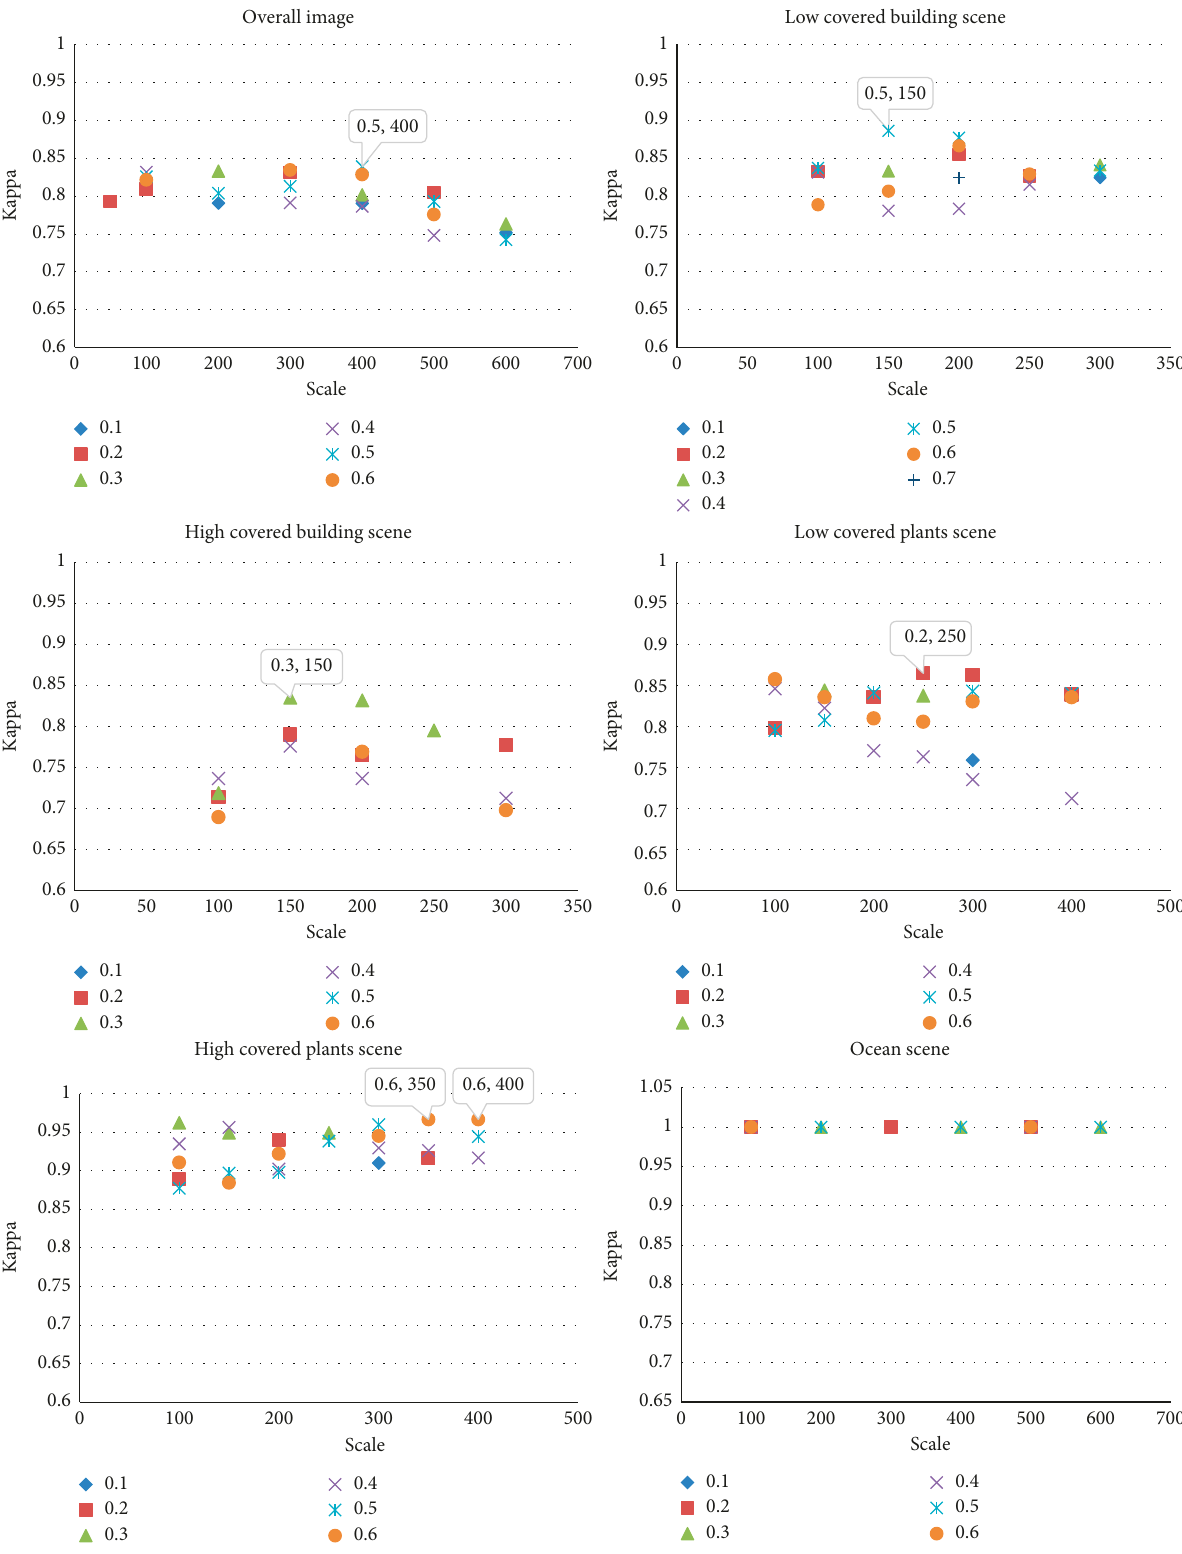
Figure 5: Scene and scene merged images’ kappa coefficients of image